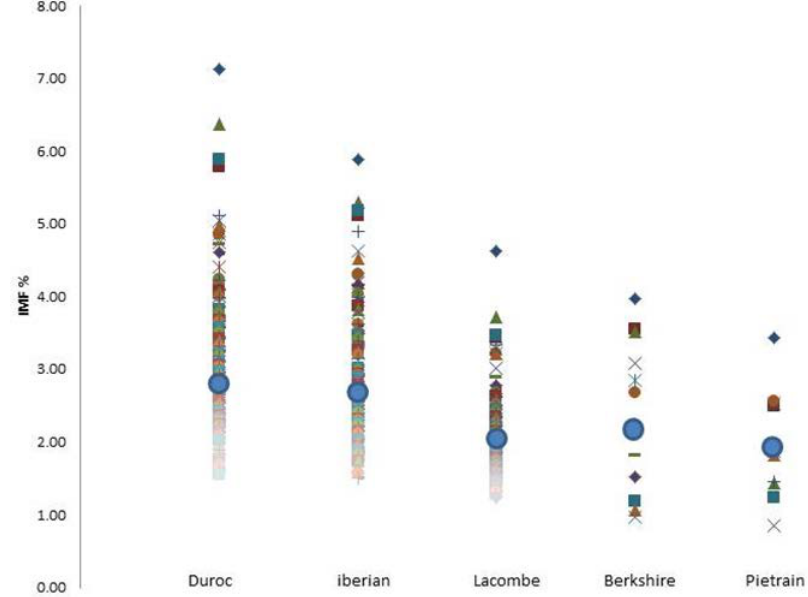
Figure 1. The average intramuscular fat percentage (IMF %) in the longissimus dorsi muscle of the five cross breeds. The IMF % was calculated on the lean muscle using an NMR analyser. The overall average IMF mean percentage ( µ ± std dev) is represented by the blue dot within each breed sire subgroup: Duroc 2.9 ± 0.7%, Iberian 2.8 ± 0.6%, Lacombe 2.0 ± 0.4%, Berkshire 2.4 ± 0.8%, and Pietrain 2.0 ± 0.6%.